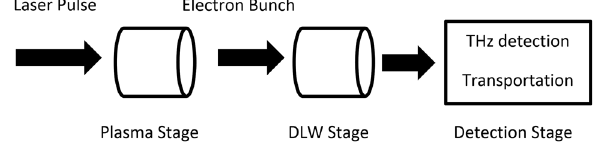
FIG. 7. Schematic of THz generation without magnetic capture and transport lines.